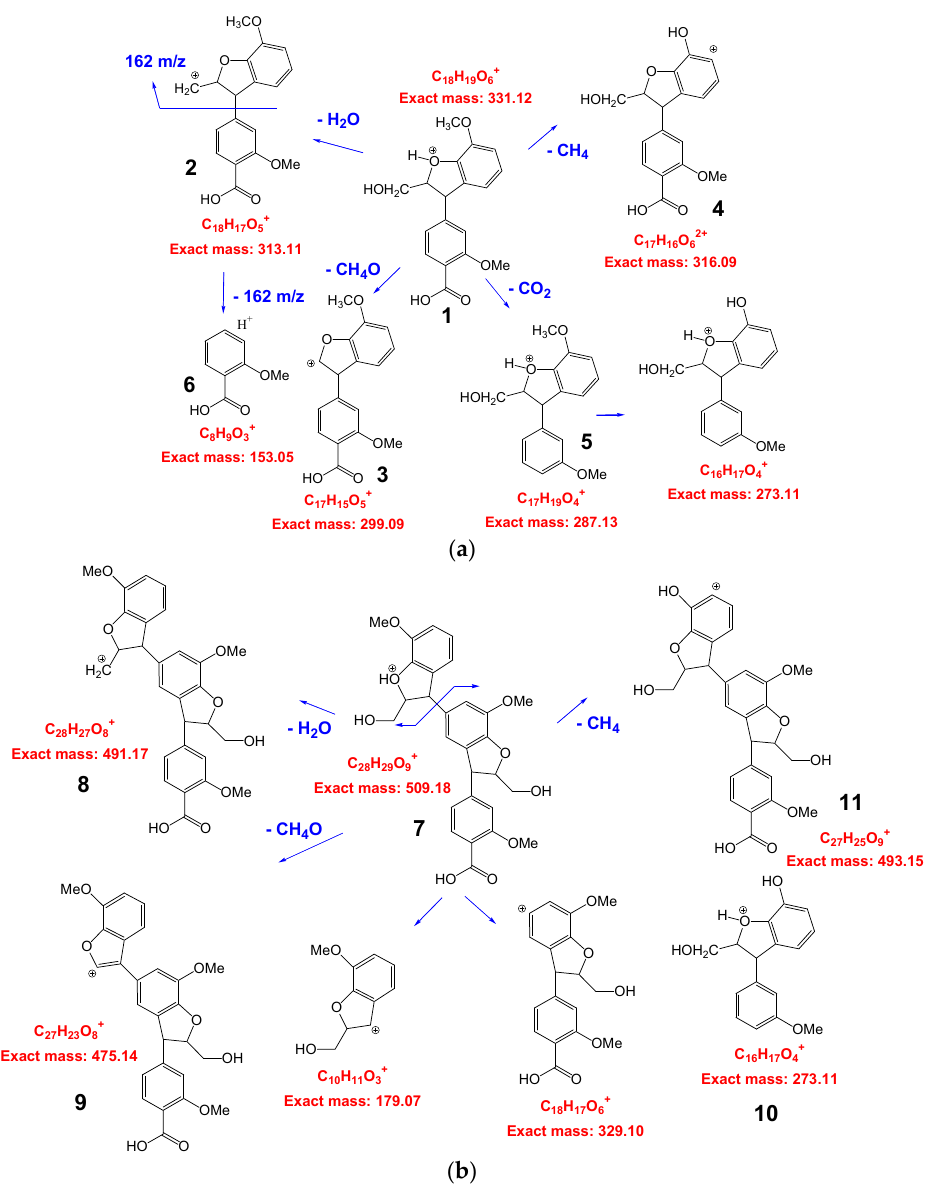
Figure 3. Tentative breakdown processes in the MS/MS of 1 ( a ) and 7 ( b ).